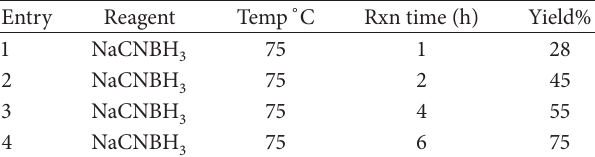
Table 6: Reaction time